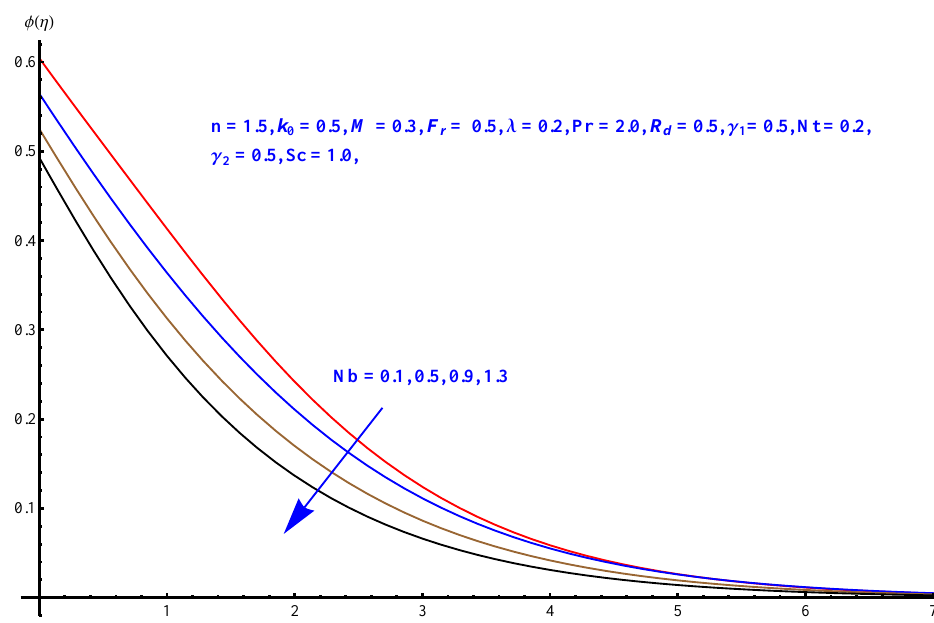
Figure 12. Brownian diffusion versus concentration distribution.